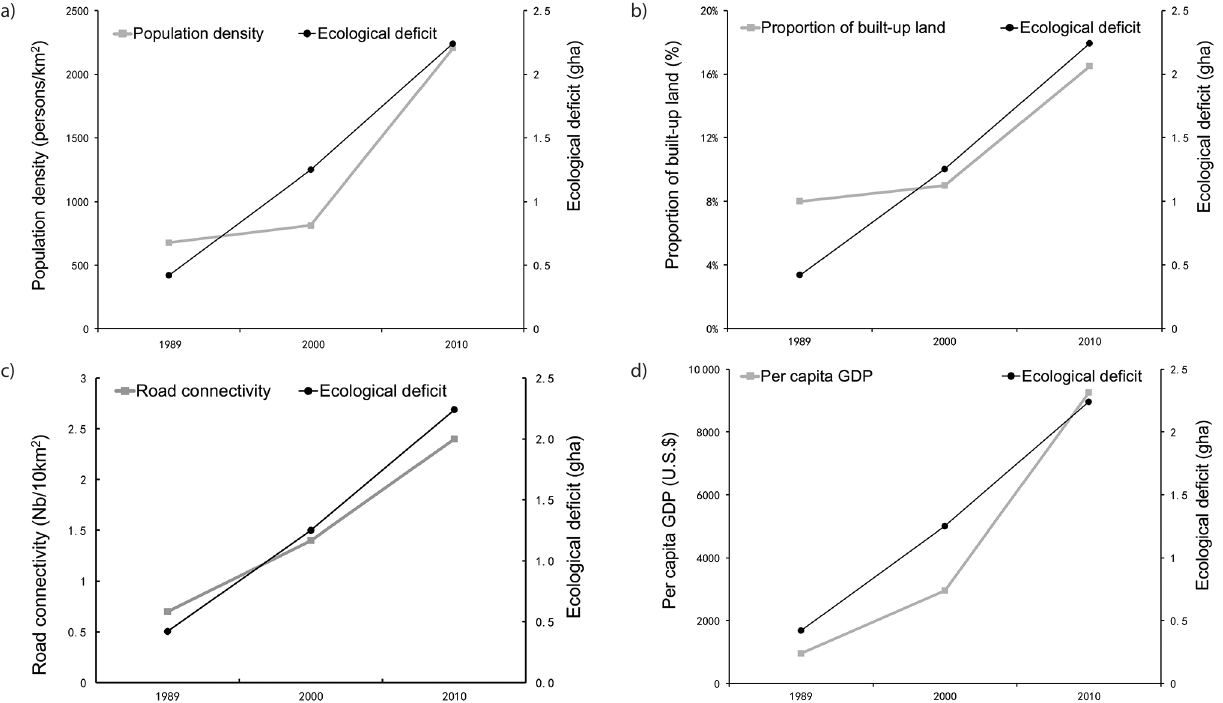
Figure 10. Change trend of EF with DMA and GDP factors from 1989 to 2010 in Xiamen City (figure drawn by the